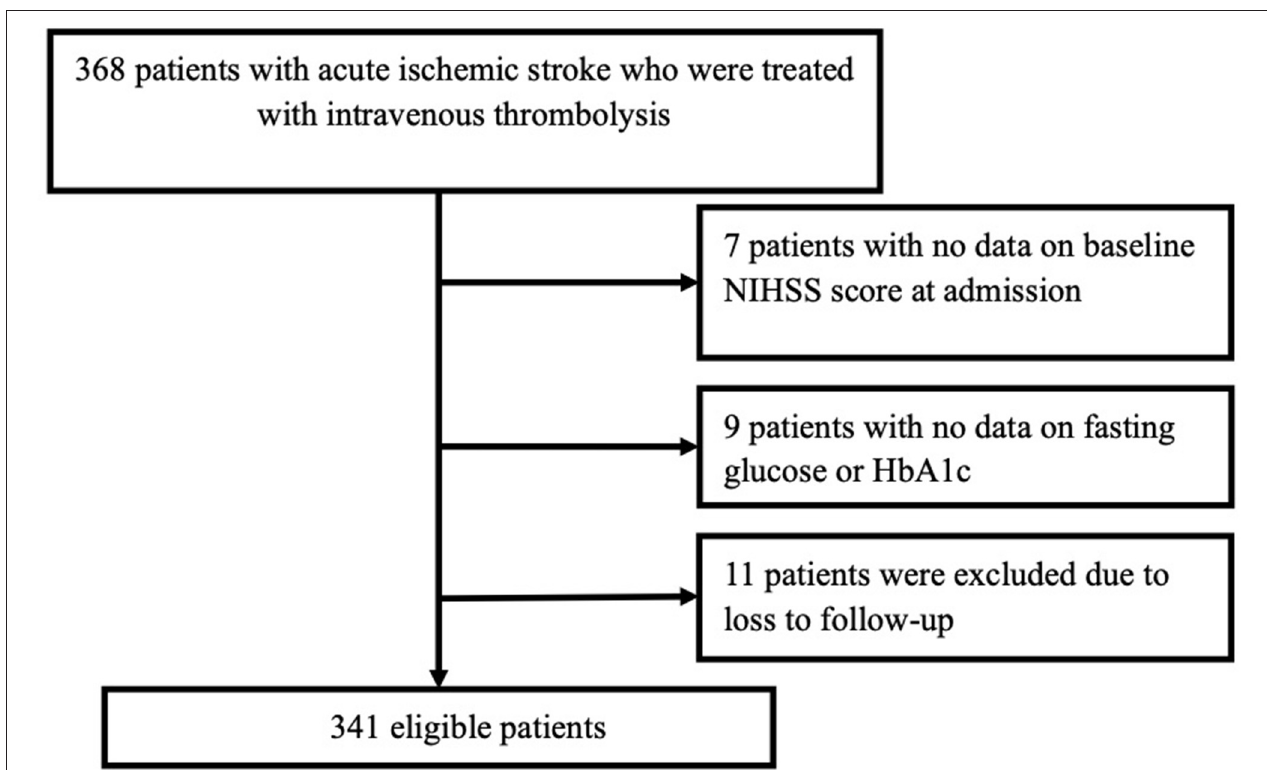
FIGURE 1 | A flow diagram showing the patient selection